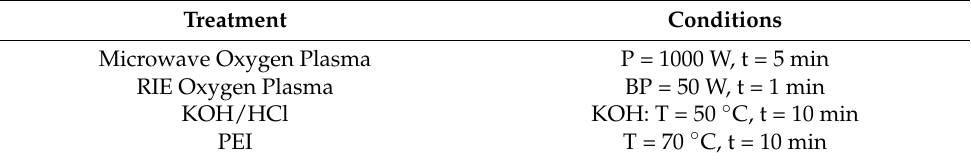
Table 3. Selected treatment conditions for scratch and peel test of PI